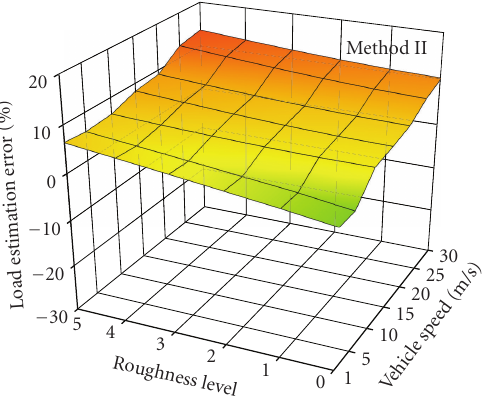
Figure 7: The rear axle load estimation error of vehicle load under various roughness levels and vehicle speeds using Method II. Table 2: Estimation errors of axle weights for di ff erent sampling rate and number of beam elements. Sampling